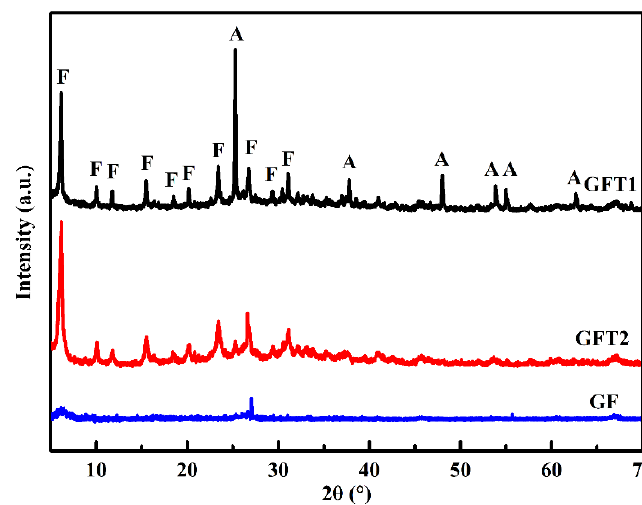
Figure 1. XRD patterns of the geopolymer (GF) and the geopolymer-TiO 2 composites obtained by two different approach. A — anatase, F — faujasite.